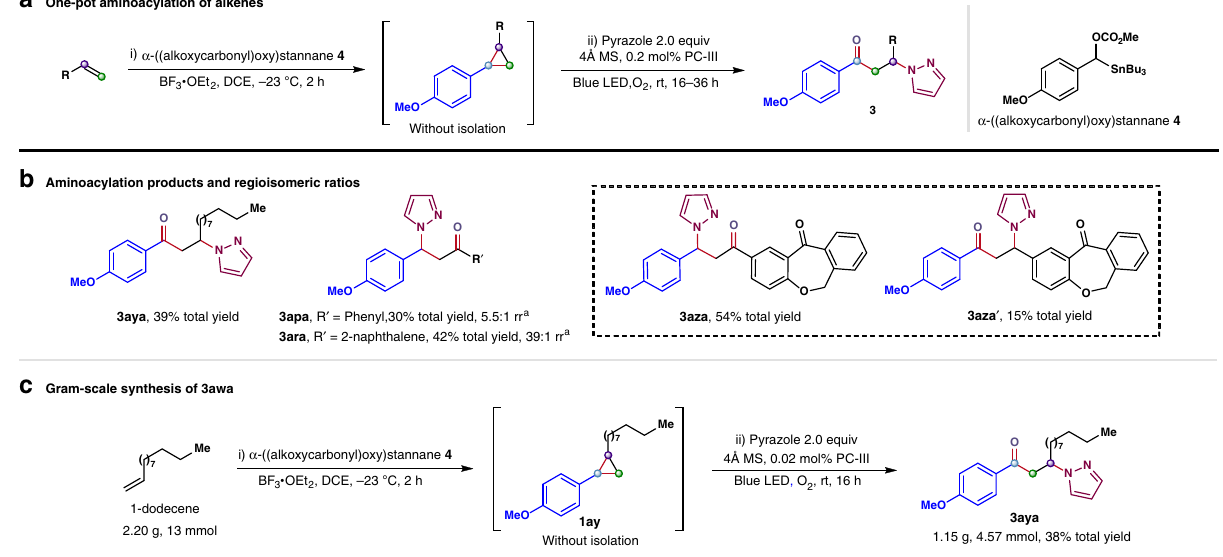
Fig. 2 Telescoped reactions and scale-up experiments. a One-pot formal aminoacylation of alkenes. b Additional products and their regioselectivity. c Gram-scale reaction to form 3aya . a The isolated yield of the major isomer is listed. rr is regioisomeric ratio, represents the ratio of major isomer to the minor one. PC photoredox catalyst, DCE 1,2-dichloroethane, MS molecular